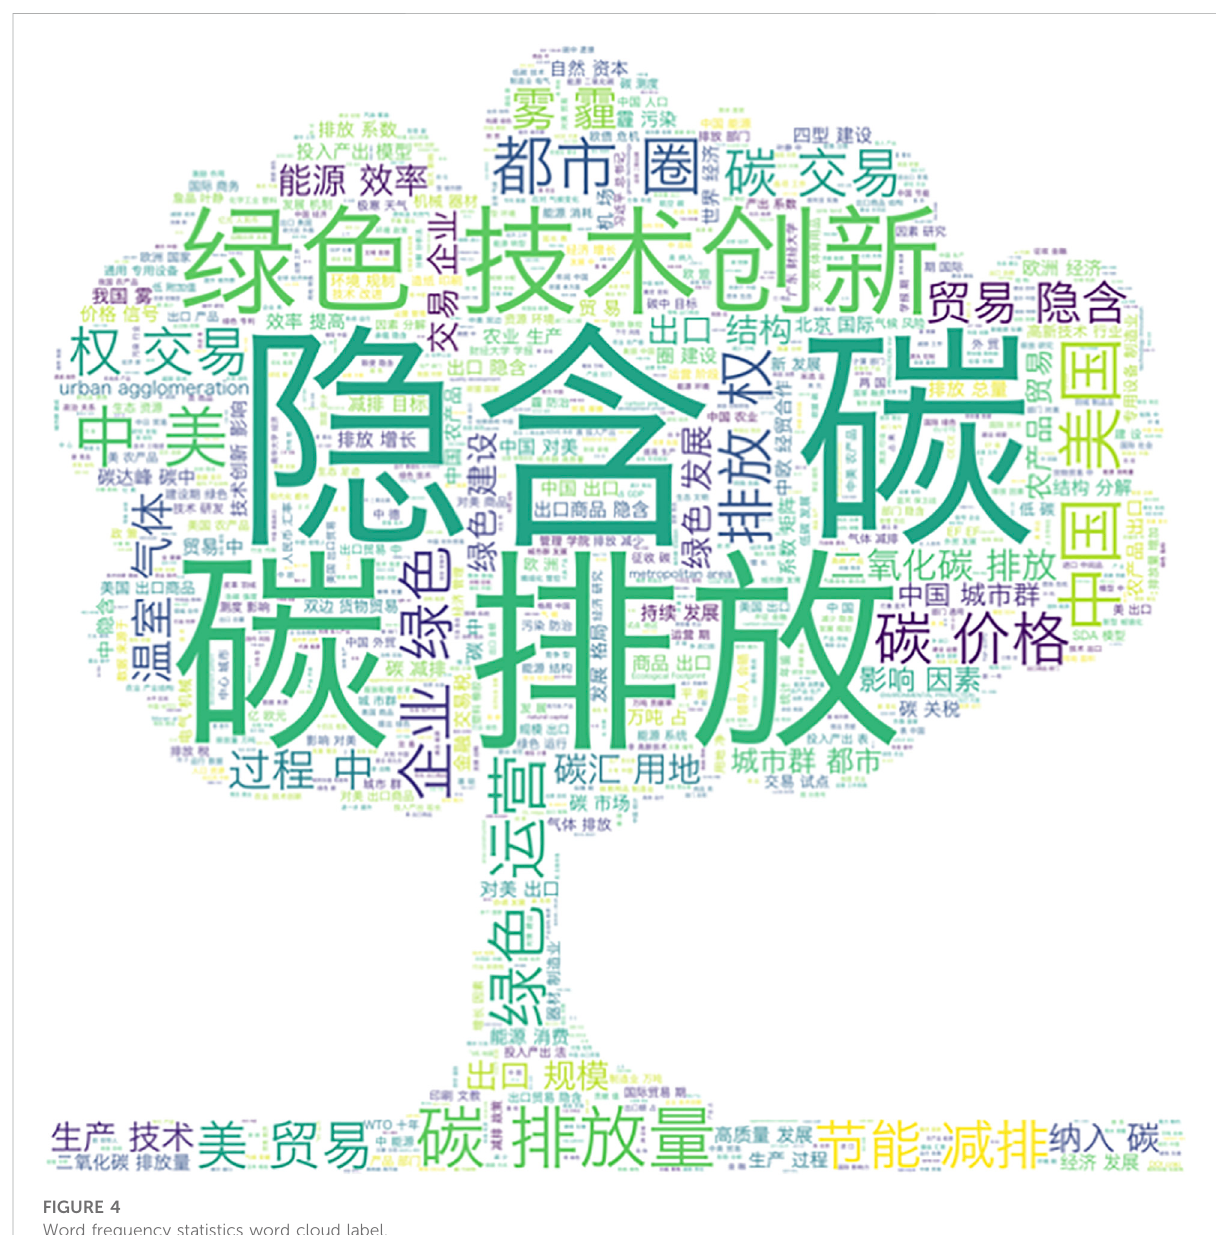
FIGURE 4 Word frequency statistics word cloud